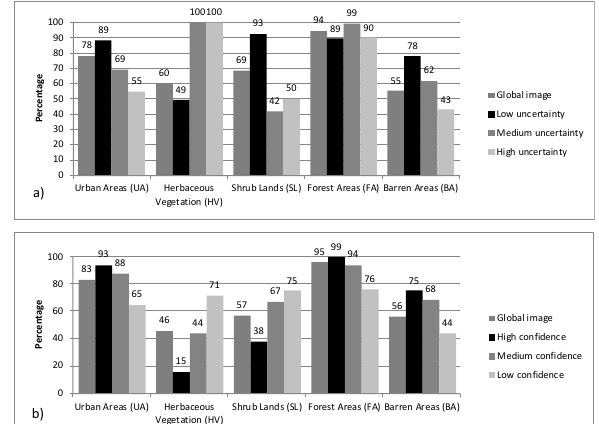
Figure 6. User’s accuracy per class of a) the global image and of the regions with low, medium and high uncertainty computed using the RMD, b) the global image and the regions with high, medium and low confidence